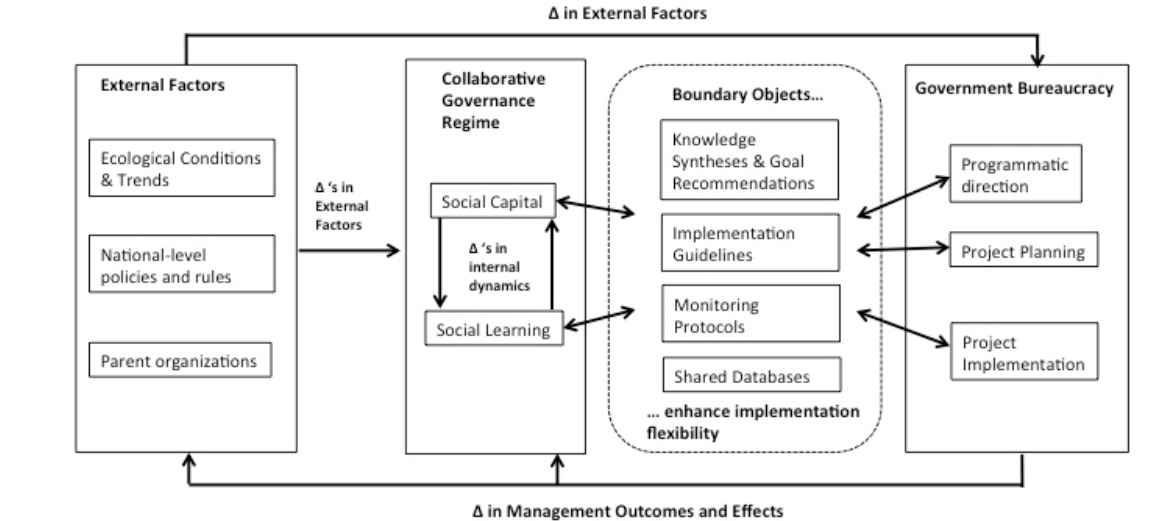
Fig. 2. Framework for examining the adaptability of public ecosystem management collaborative governance